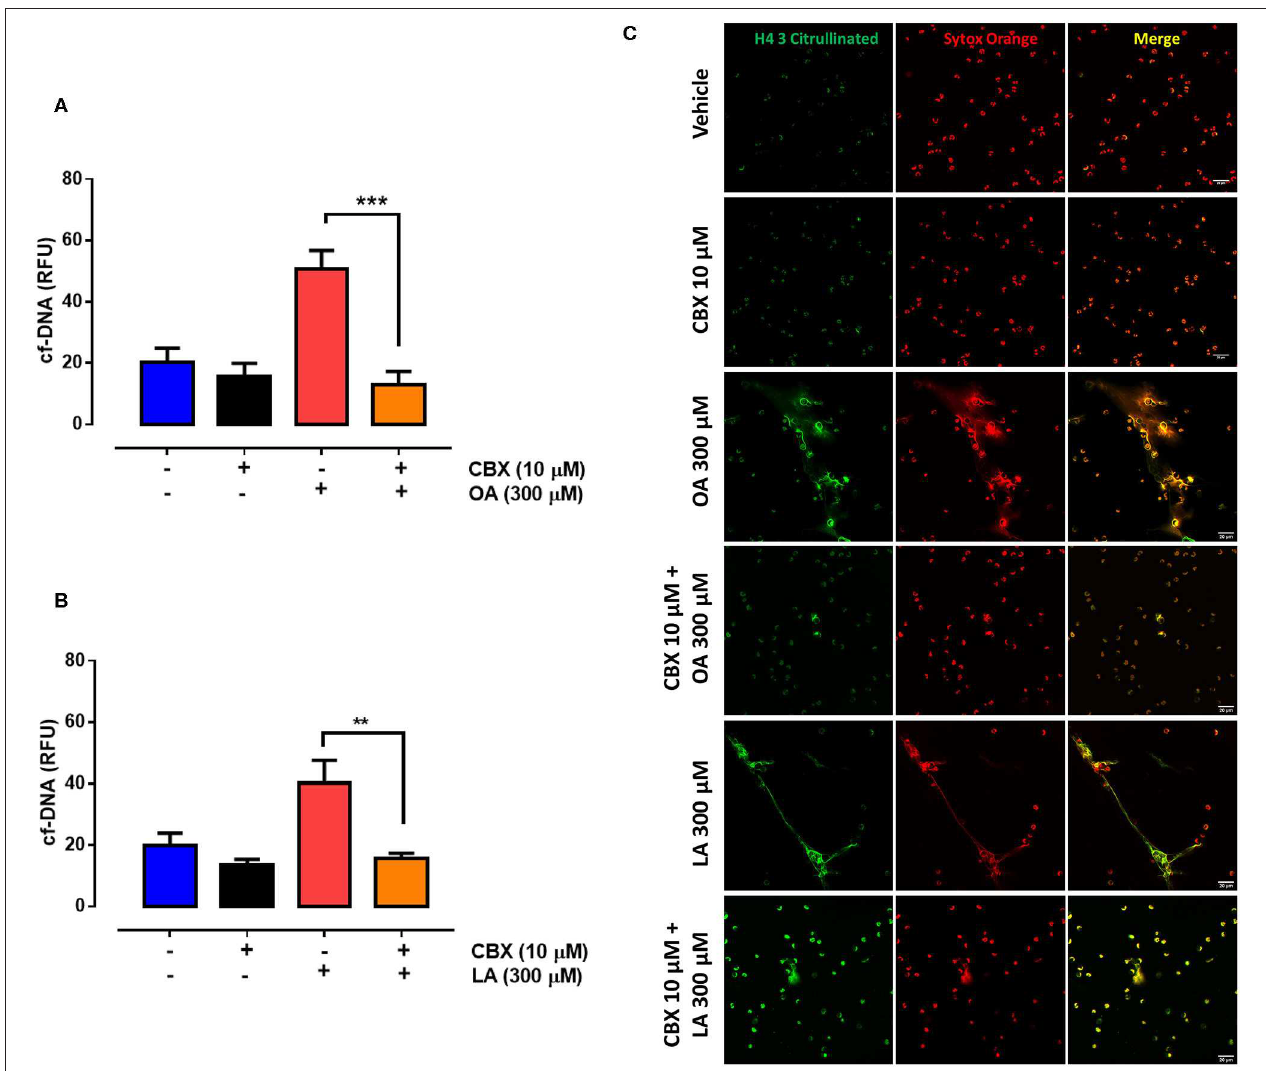
FIGURE 4 | Oleic acid (OA) and linoleic acid (LA) induce neutrophil extracellular trap (NET) formation via PANX1-mediated ATP release. Bar graph (means ± S.E.M.) of cell-free (cf)-DNA of PMN treated with 10 µ M carbenoxolone (CBX) for 15min and stimulated or not with OA (A) or LA (B) . n = 4; ** p < 0.01, *** p < 0.001 compared with OA or LA treatment alone. Representative image from four independent experiments of PMN treated with CBX and stimulated with OA or LA (C) .